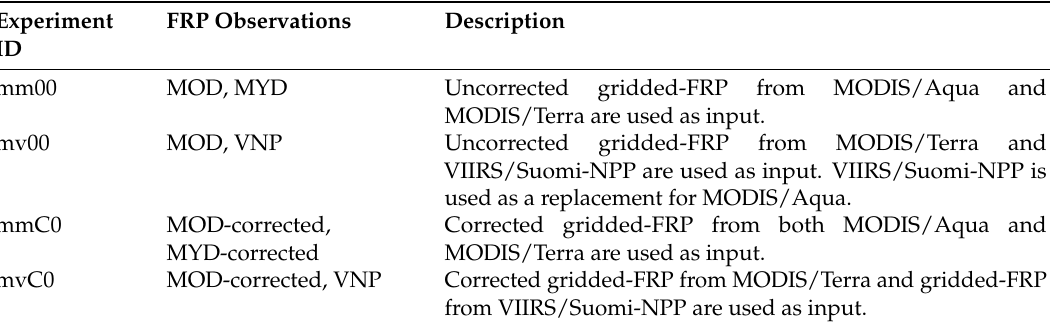
Table 1. Overview of different experiments with Global Fire Assimilation System (GFAS). The column FRP observations (Fire Radiative Power) describes the input from different satellite platforms. The suffix “corrected” refers to observations after bias correction. Abbreviations: MOD = Moderate